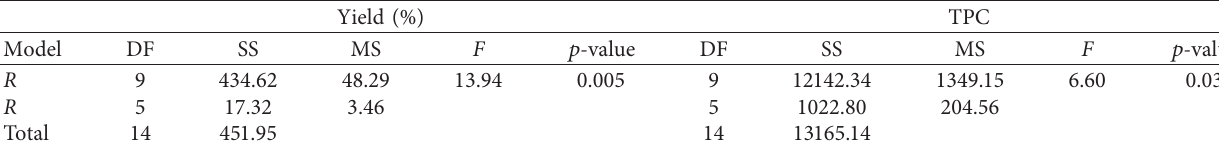
Table 3: Analysis of variance for the fitted models.